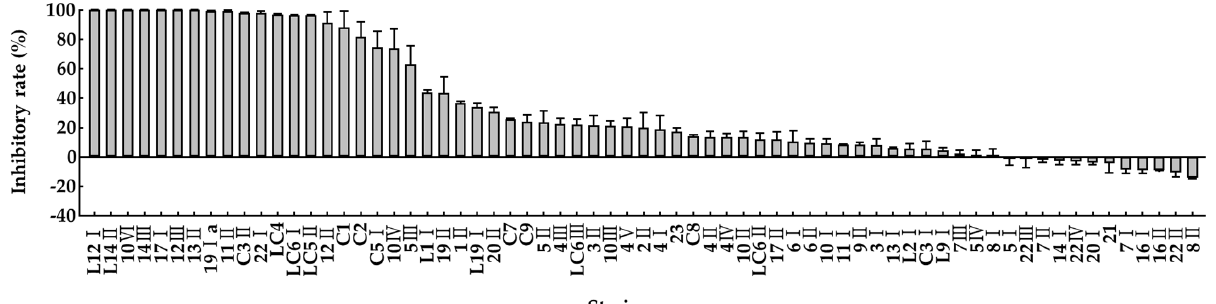
Figure 4. Inhibitory effects of liquid culture of candidate bacterial strains against the urease activity by using phenol red method at 560 nm. Values represent the mean ± S.E. ( n = 3).